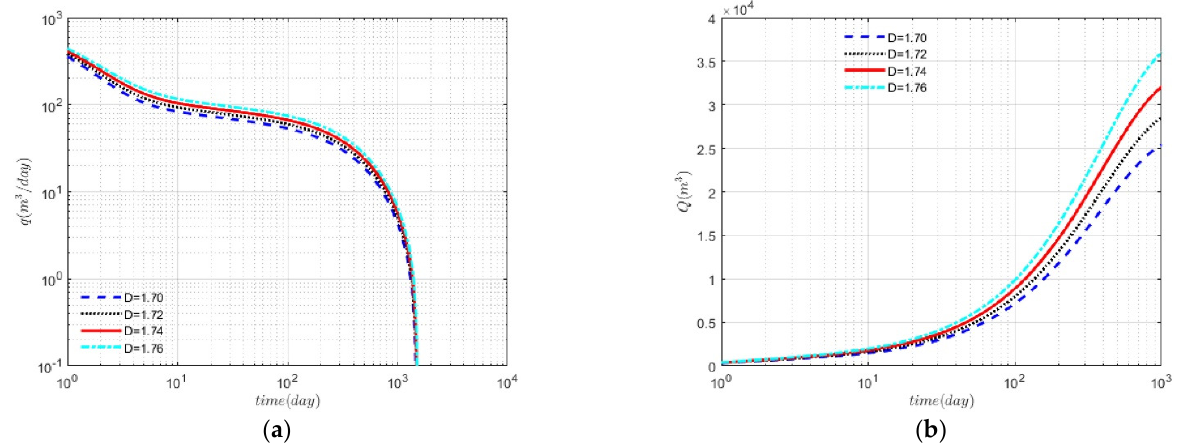
Figure 11. The effect of the fractal dimension on productivity: ( a ) effect of the fractal dimension on well production rate;